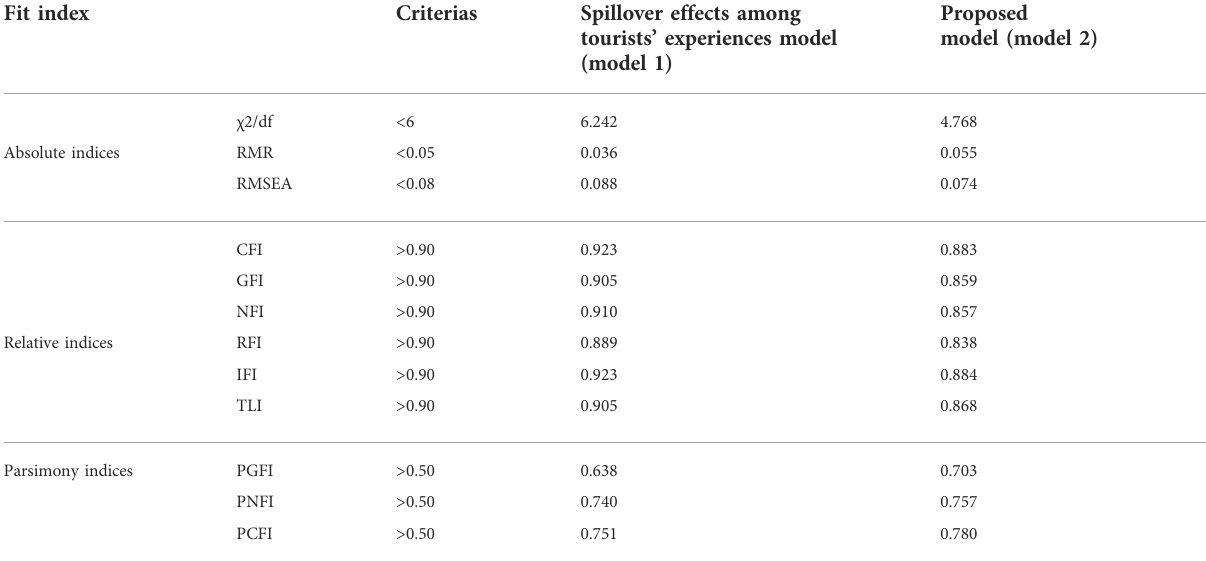
TABLE 3 Model fi tting